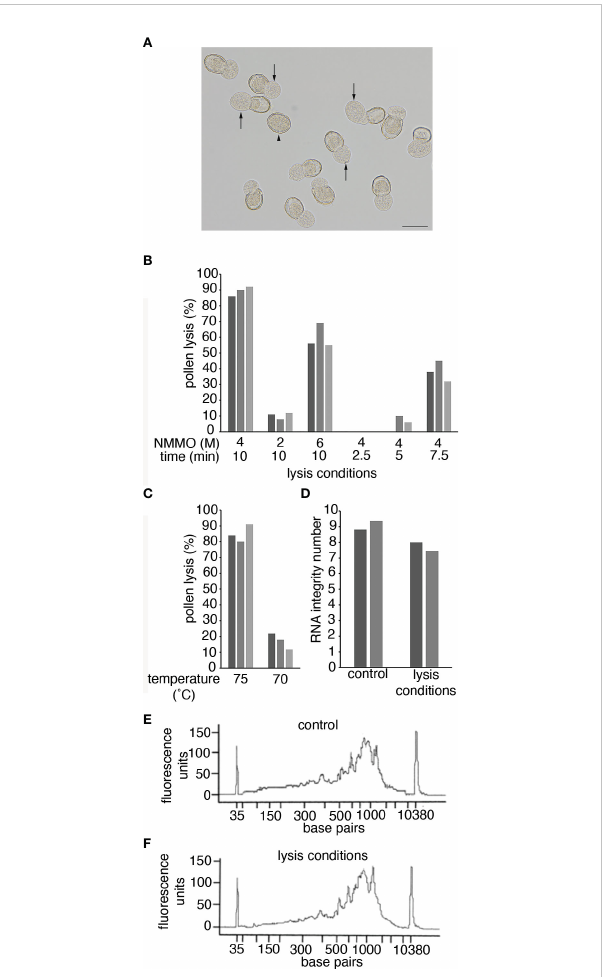
FIGURE 2 Pollen lysis using NMMO. (A) Pollen from a -1 Arabidopsis bud after incubation in 4 M NMMO at 75°C for 10 min. Arrows indicate where the sporoplast is extruded from the pollen wall in a lysed pollen grain. The arrowhead indicates an unlysed pollen grain. Scale bar = 20 m m. (B, C) Pollen lysis ef fi ciency. Pollen grains from anthers from -1 Arabidopsis buds were incubated on a microscope slide under different conditions. Pollen was incubated at 75°C at different NMMO concentrations and for different times (B) or in 4 M NMMO for 10 min at different temperatures (C) . To determine lysis ef fi ciency 100 Arabidopsis pollen grains were observed for sporoplast extrusion, as shown in (A) . The experiment was repeated on three occasions with each experiment represented by a separate bar. (D) The impact of pollen-lysis conditions on RNA quality. RNA Integrity of two Arabidopsis leaf RNA samples (separate bars) with and without exposure to pollen lysis conditions (4 M NMMO at 75°C for 10 min). (E, F) The impact of pollen lysis conditions on cDNA synthesis. The fragment size distribution of cDNA libraries prepared from a kiwifruit leaf RNA sample incubated on ice (control; E ) or exposed to pollen lysis conditions (F)